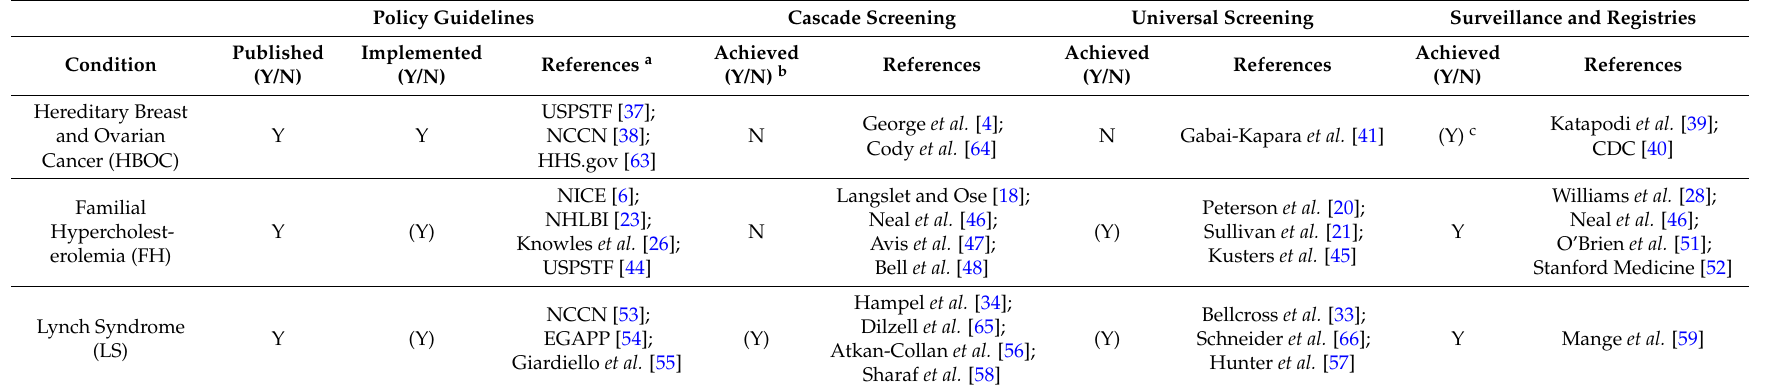
Table 3. Tier 1 Genetic testing—Current